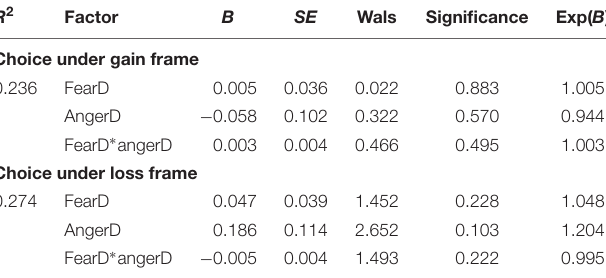
TABLE 2 | Regression of choices on dispositional